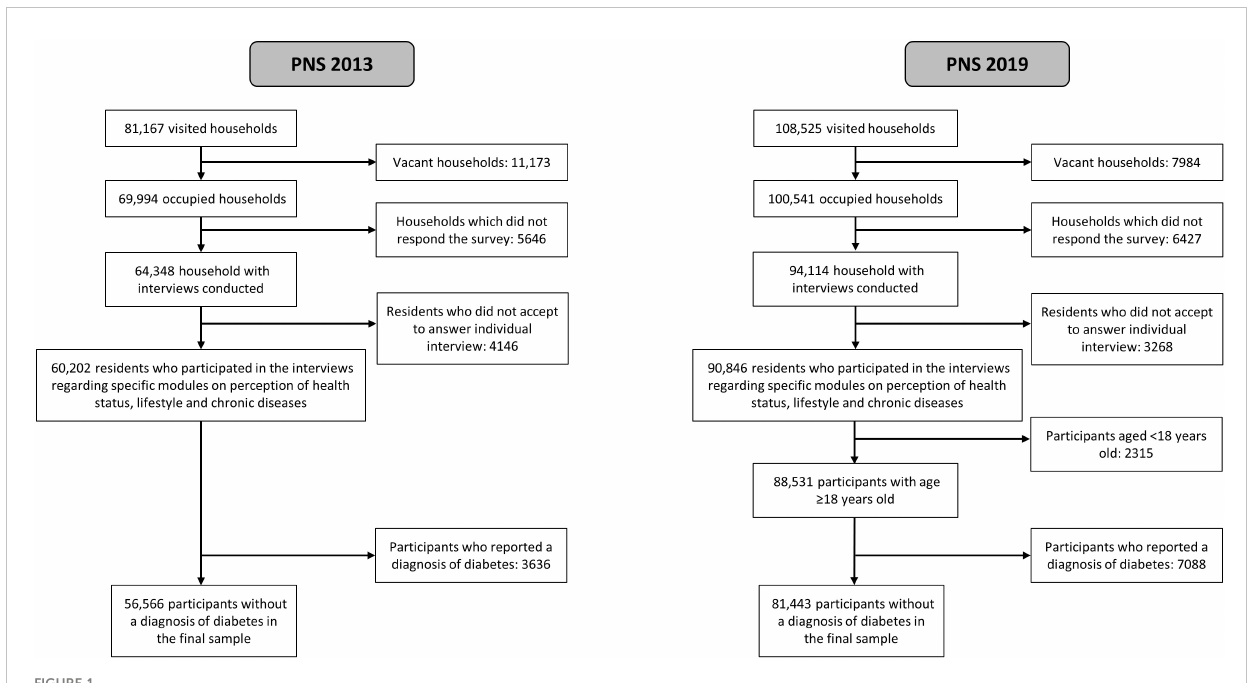
FIGURE 1 Flowchart of study participants, Brazilian National Health Survey, 2013 and